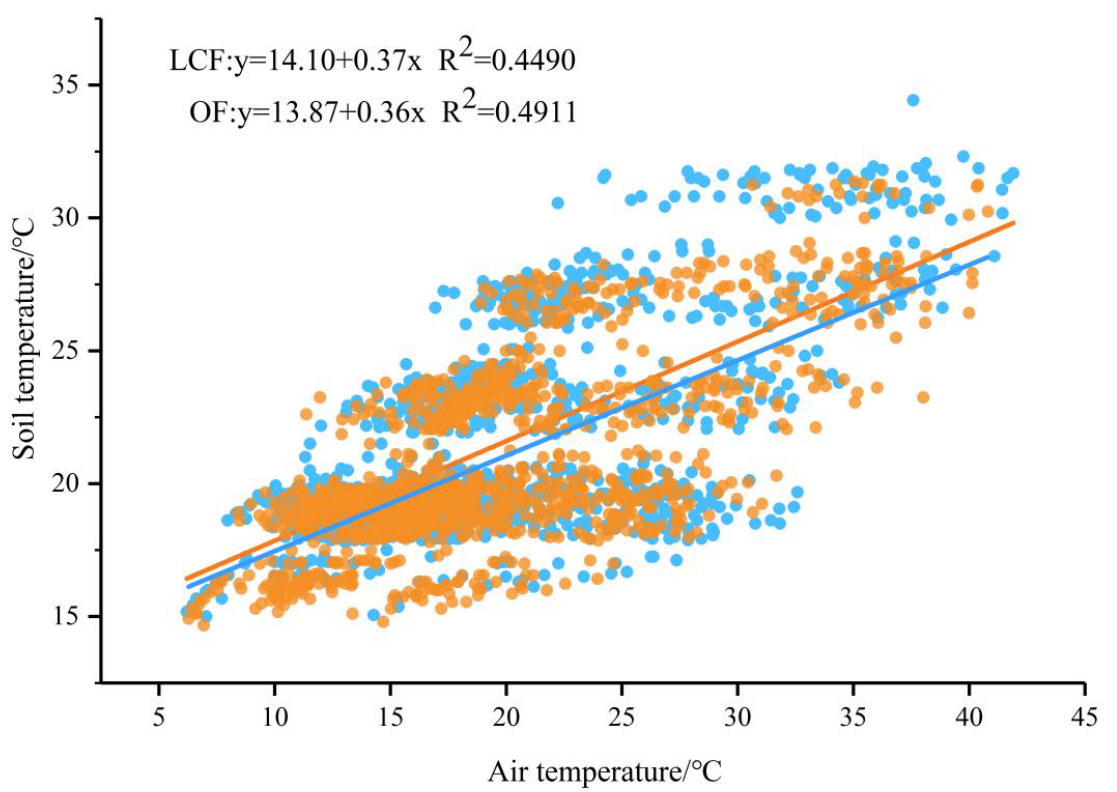
Figure 13. Correlation between air temperature and soil temperature under light conversion film (LCF) and ordinary film (OF). (The yellow dots indicate the correlation between light conversion film and air temperature and soil temperature, and the blue dots indicate the correlation of common membrane to air temperature and soil temperature.).